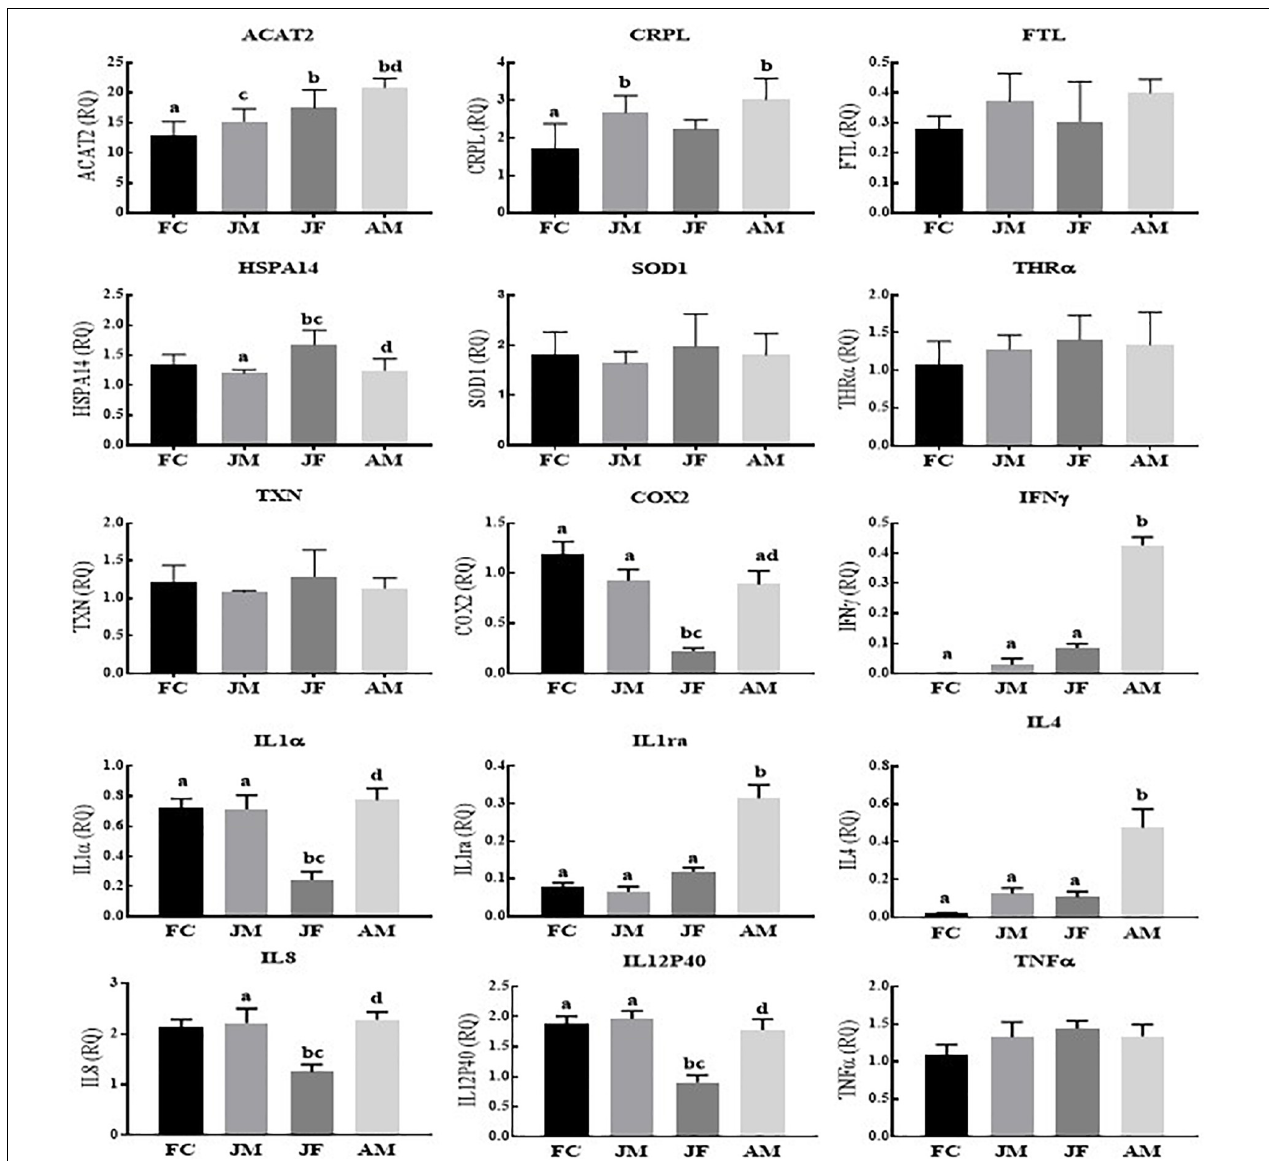
FIGURE 1 | Yangtze finless porpoises (YFPs) living in Poyang Lake across the age groups. Each parameter followed by an alternate letter was significantly different at P ≤ 0.05. FC, Female calves; JM, Juvenile males; JF, Juvenile females; AM, Adult males.